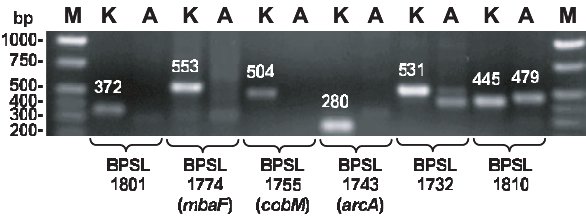
Figure 5. Deleted genes are absent from the 708a genome. PCR was performed with genomic DNA isolated from K strain K96243 or A strain 708a with gene-specific primers. These included 2037 & 2038 for Figure 4. Strain 708a is fully virulent in an acute murine BPSL1801 , 2035 & 2036 for BPSL1774 , 2033 & 2034 for BPSL1755 , 1954 & melioidosis infection model. BALB/c mice ( n =4–5 mice) were N 1955 for BPSL1743 , 2031 & 2032 for BPSL1732 , and 1742 & 1743 for infected intranasally with 5 6 10 3 CFUs of 1026b & , 5 6 10 3 CFUs of strain BPSL1810 . PCR products were separated on a 1% agarose gel and or 5 6 10 4 # colony forming units of the 708a m , and 5 6 10 3 stained with ethidium bromide. Sizes of the expected PCR fragments (in isogenetic D ( amrRAB-oprA ) 1026b derivative Bp50. Statistical differenc- bp and based on K96243 genomic sequence) are indicated above the es in survival times were determined by Kaplan-Meier curves followed respective bands. Gene annotations are according to K96243 and gene by log-rank test. The Bonferroni corrected threshold was applied and names, where known, are in parentheses. Lanes M contained the Hi-Lo comparisons with p , 0.017 were considered significant. (**, p , 0.01 for DNA ladder (Minnesota Molecular, Minneapolis, MN) and the sizes of strain 1026b vs. Bp50 (5,000 CFU) and 708a vs. Bp50 (5,000 CFU). Data pertinent fragments are indicated on the left. are representative of 2 independent